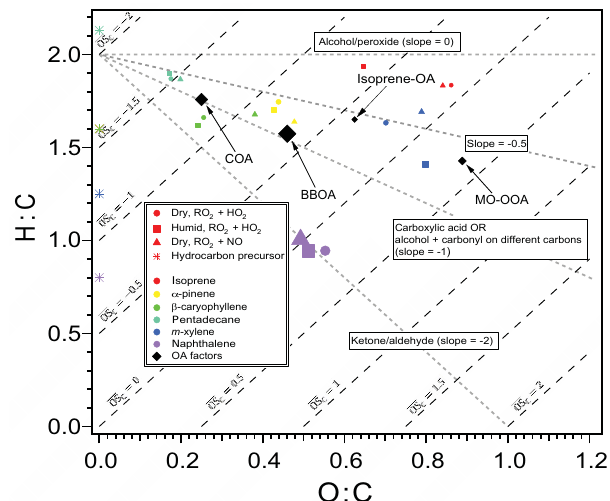
Figure 3. Van Krevelen plot for various SOA systems. Data points are colored by SOA system (red: isoprene, yellow: α -pinene, green: β -caryophyllene, light blue: pentadecane, blue: m -xylene, and pur- ple: naphthalene), shaped according to reaction conditions (circle: dry, RO 2 + HO 2 ; square: humid, RO 2 + HO 2 ; and triangle: dry, RO 2 + NO), and sized by intrinsic DTT activity. OA factors re- solved from PMF analysis of ambient AMS data are shown as black markers, also sized by intrinsic DTT activity. Hydrocarbon precursors are shown as stars, colored by SOA system. Specifics on site locations and factor resolution methods are described else- where. COA: cooking OA, BBOA: biomass burning OA, Isoprene- OA: isoprene-derived OA, MO-OOA: more-oxidized oxygenated OA (Verma et al., 2015a; Xu et al., 2015a,